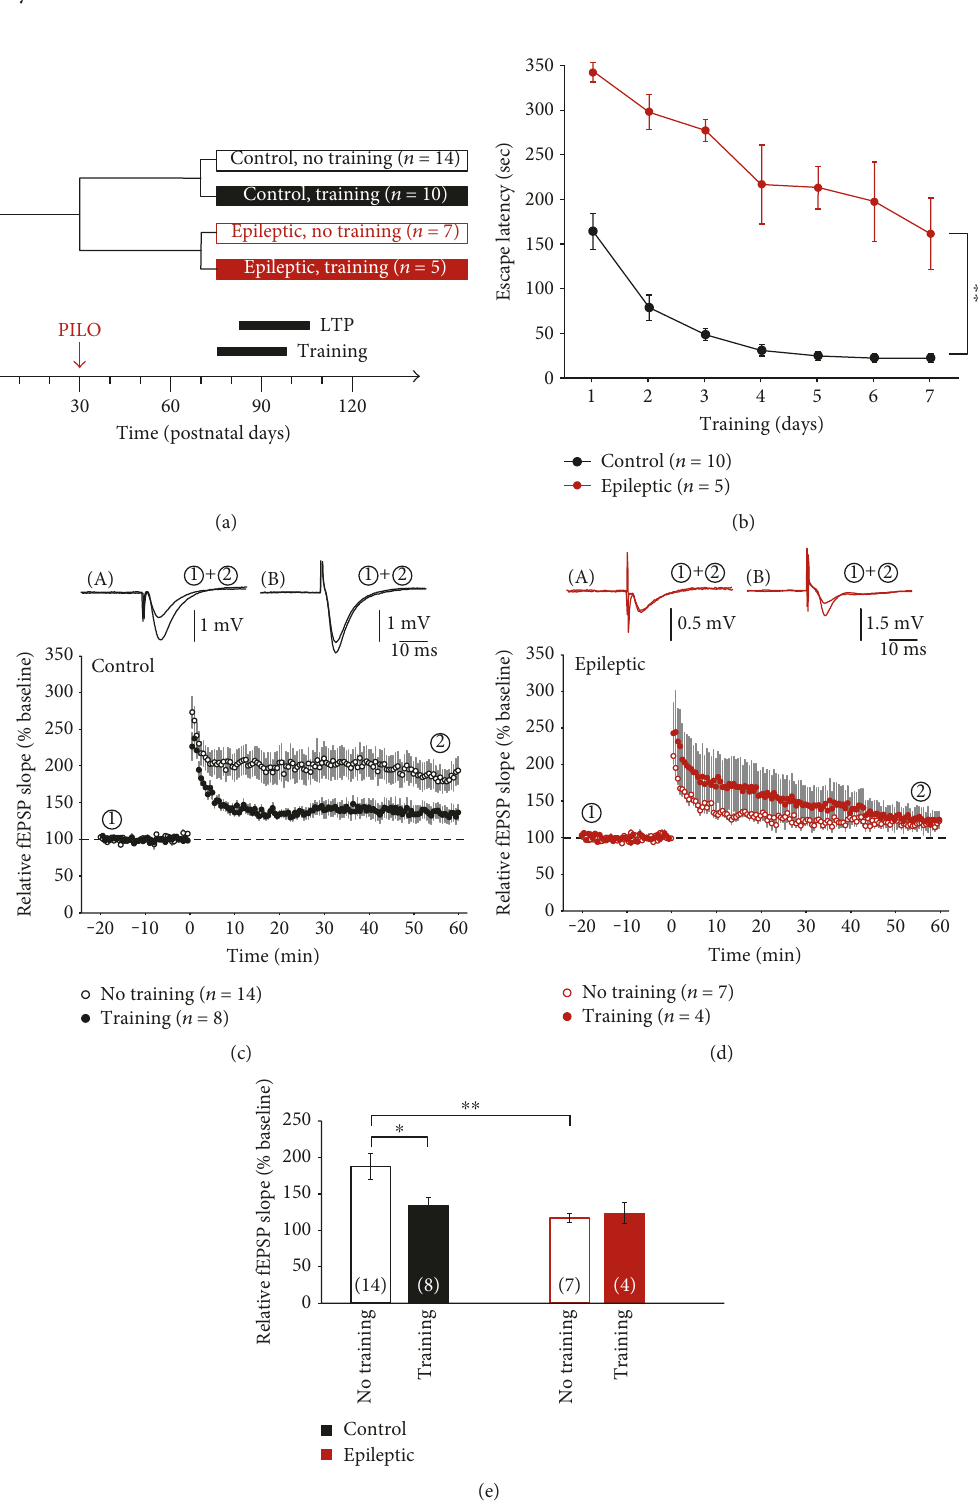
Figure 1: Functional metaplasticity by spatial memory training in adolescent rats. (a) Experimental paradigm indicating pilocarpine-induced status epilepticus (PILO) and time points of both training and LTP (which was always tested one day after completing seven days of training). Four groups of animals were tested (control and epileptic rats, with or without training). (b) Spatial memory acquisition (as assessed by the cumulative escape latency of six consecutive trials per day) was signi fi cantly impaired in epileptic animals (red symbols) compared to controls (black symbols). (c, d) Spatial memory training ( fi lled symbols) signi fi cantly reduced subsequent CA1-LTP in vitro in controls as compared to untrained controls (open symbols) but had no signi fi cant e ff ect on CA1-LTP in epileptic animals. (e) Bar graphs summarizing CA1-LTP levels of the four groups of animals. ∗ P < 0 05 and ∗∗ P < 0 01